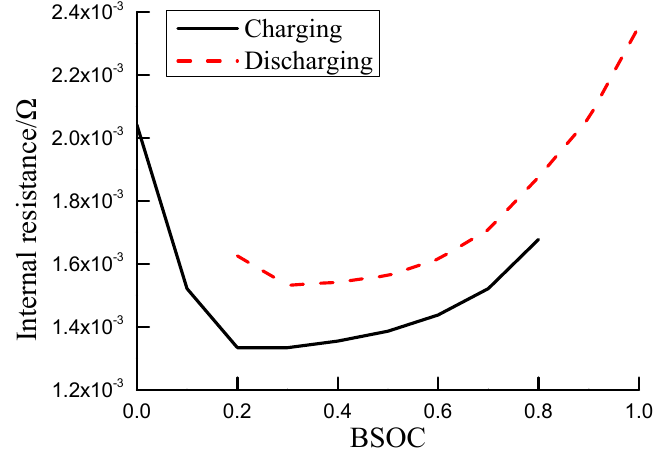
Figure 6. Relationship between internal resistance and BSOC during charging and discharging of the battery [19].